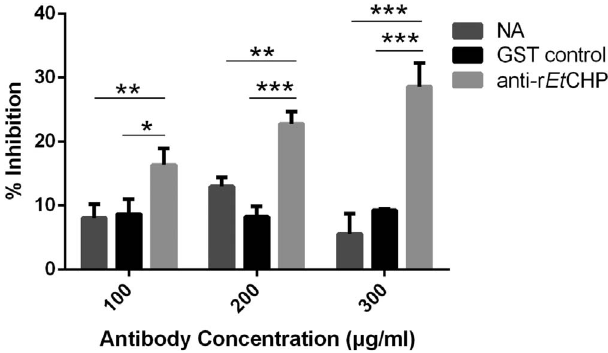
Figure 7. Inhibition of sporozoite invasion in vitro by anti- r Et CHP18905. Anti-r Et CHP18905, rabbit anti-r Et CHP18905 IgG; NA, naïve rabbit sera IgG; GST control, rabbit anti-GST IgG. The symbol “ * ” represents p < 0.05, “ ** ” represents p < 0.01, and “ *** ” represents p < 0.001 for comparison of treatment with anti- r Et CHP18905 and naïve rabbit sera IgG and anti-GST IgG at the same concentration. The error bars indicate the standard deviation. All assays were performed in